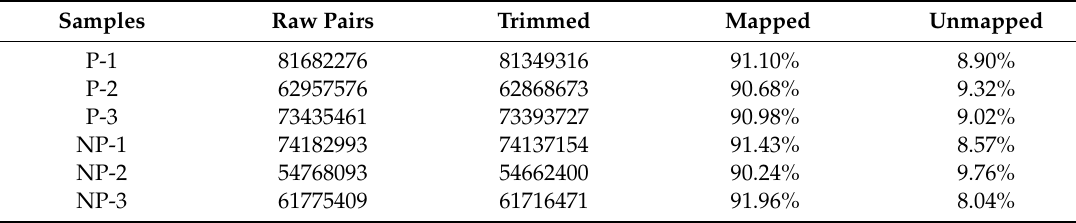
Figure 1. Workflow pipeline for sequencing, data processing, differential expression, alternative splicing, and bioinformatics analysis. Table 1. Summary of UA mRNA-Sequencing.